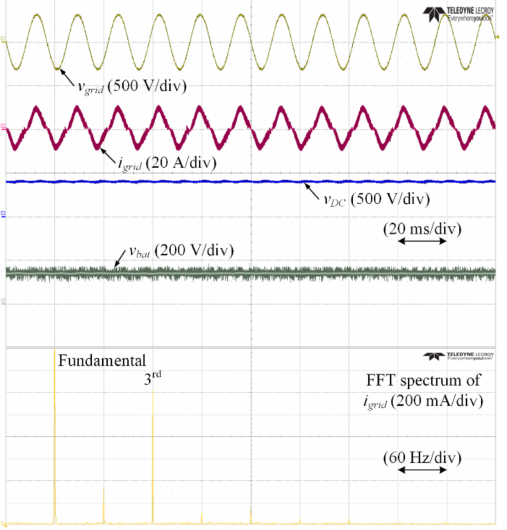
Figure 14. Experimental results of integrated OBC operated in battery charging mode.